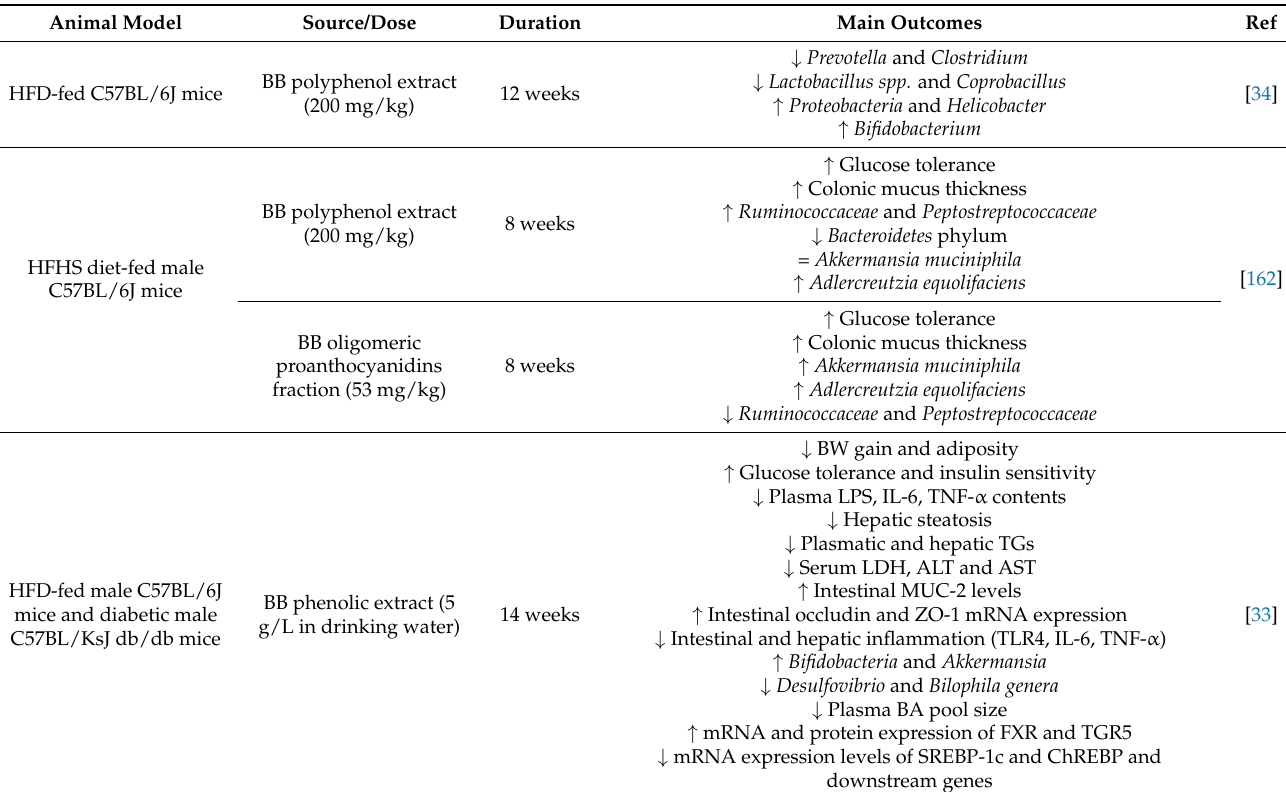
Table 3. Blueberries gut modulatory and prebiotic effects in T2DM or metabolic syndrome animal models. Animal